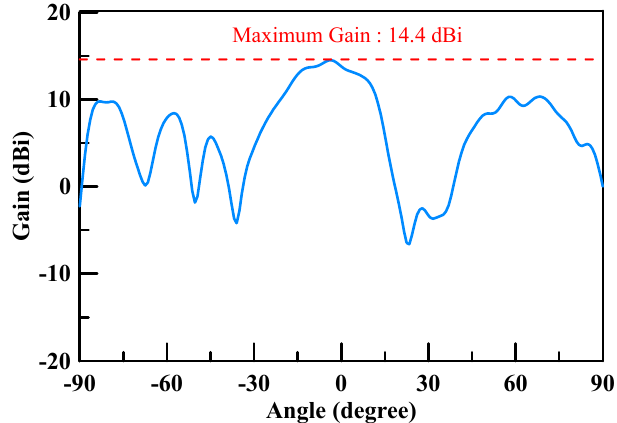
× 2) gain measurement results (phase 0 / 180 / 180 / 0, Figure 20. Array antenna (2 × 2) gain measurement results (phase 0/180/180/0, X-cut). Figure 20. Array antenna (2 Figure 20. Array antenna (2 × 2) gain measurement results (phase 0/180/180/0, X-cut). Figure 20. Array antenna (2 × 2) gain measurement results (phase 0/180/180/0, X-cut).